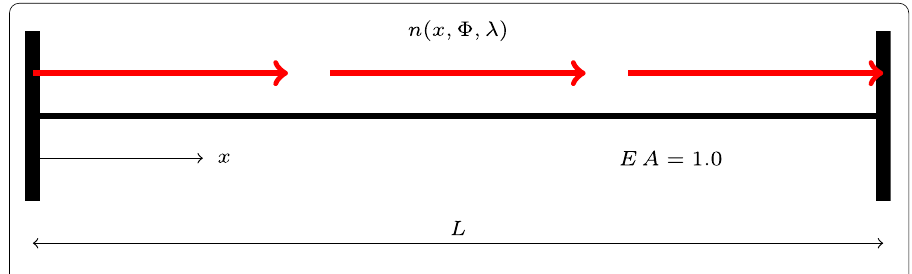
Fig. 5 Example 1D truss with geometry, boundaries and loading conditions with n ( x, (cid:12) , λ ) = λ · [cos( x + (cid:12) ) + sinh( x + (cid:12) )]